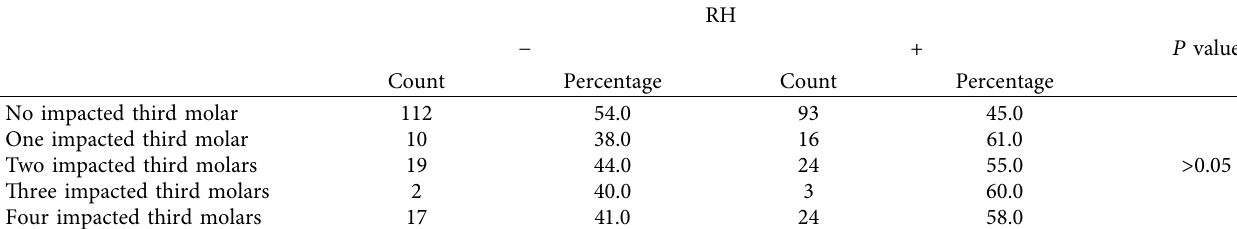
Table 3: Association between RH factor and impacted teeth.